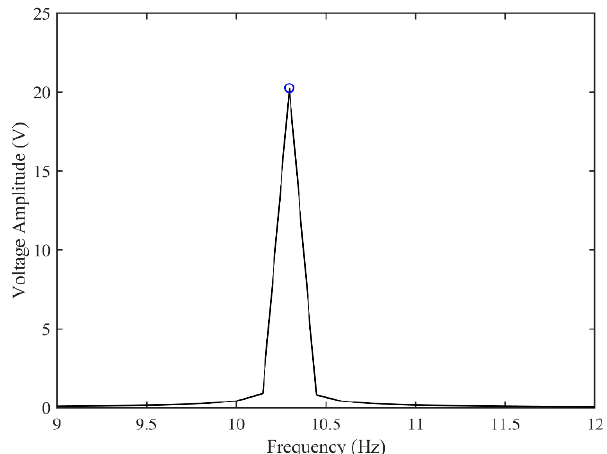
Figure 6. Fast Fourier transform (FFT) of the steady-state part of the voltage–time response. ( U = 4.0 m/s).